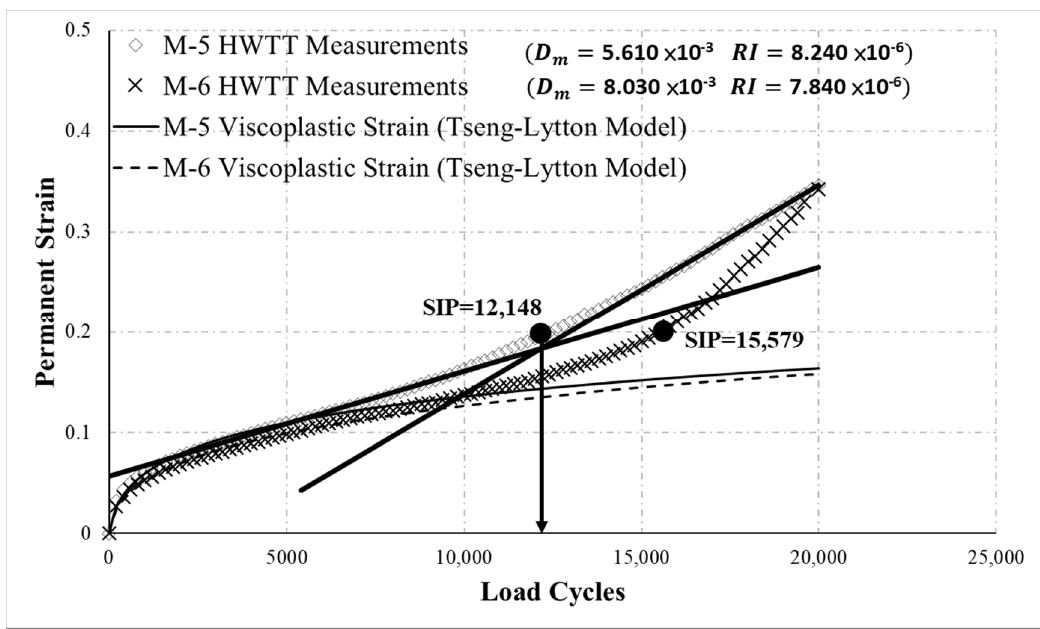
Figure 8. HWTT results for M-5 and M-6.